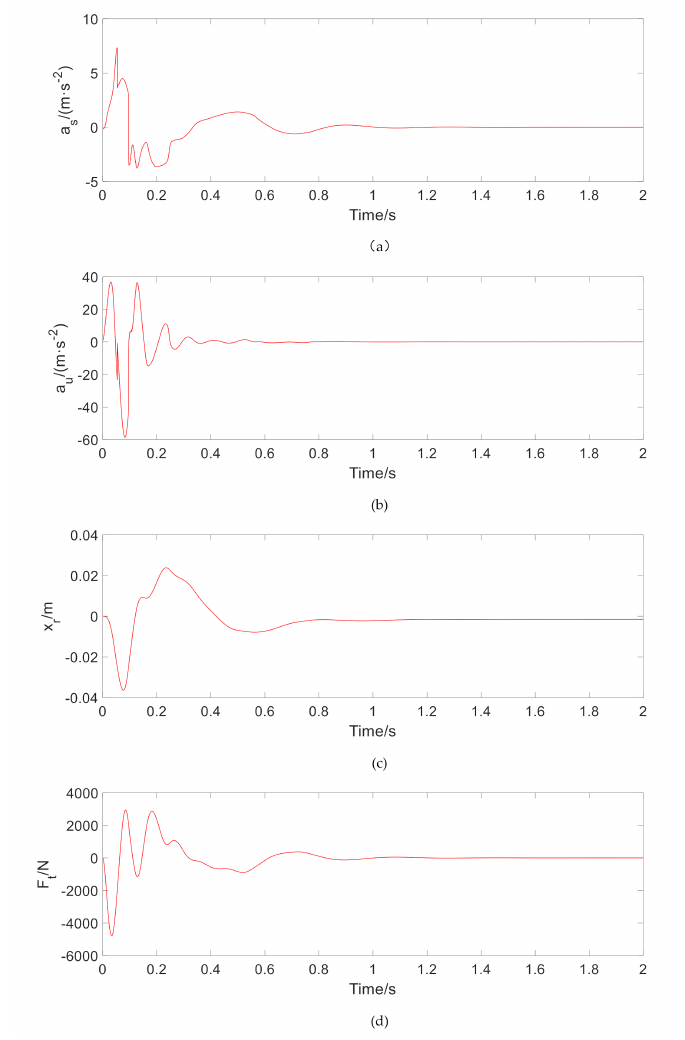
Figure 5. Dynamic characteristics under smooth pulse excitation. ( a ) Sprung mass acceleration under smooth pulse, ( b ) Free spring-mass acceleration under smooth pulse, ( c ) Suspension dynamic travel under smooth pulse, ( d ) Tire dynamic force under smooth